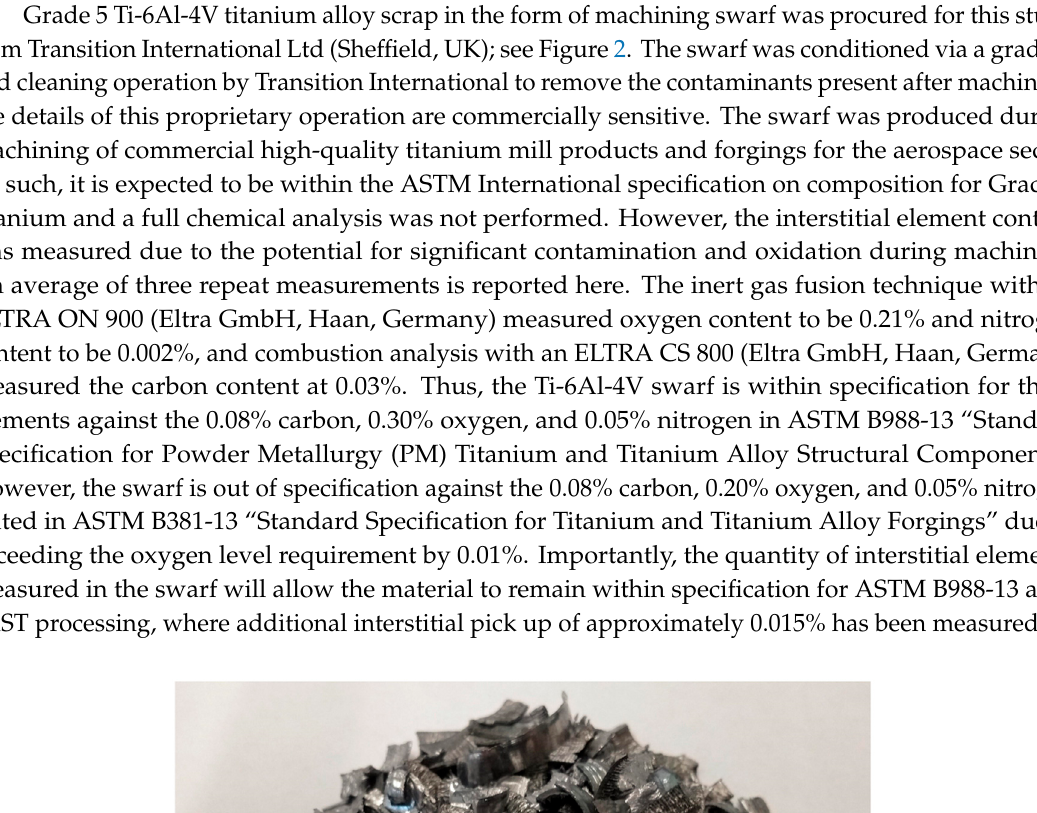
Figure 1. Schematic representing the solid-state closed-loop recycling approach, incorporating the FAST- forge process (where FAST stands for field assisted sintering technology), for sustainable production of low-cost titanium alloy components for multiple sectors.